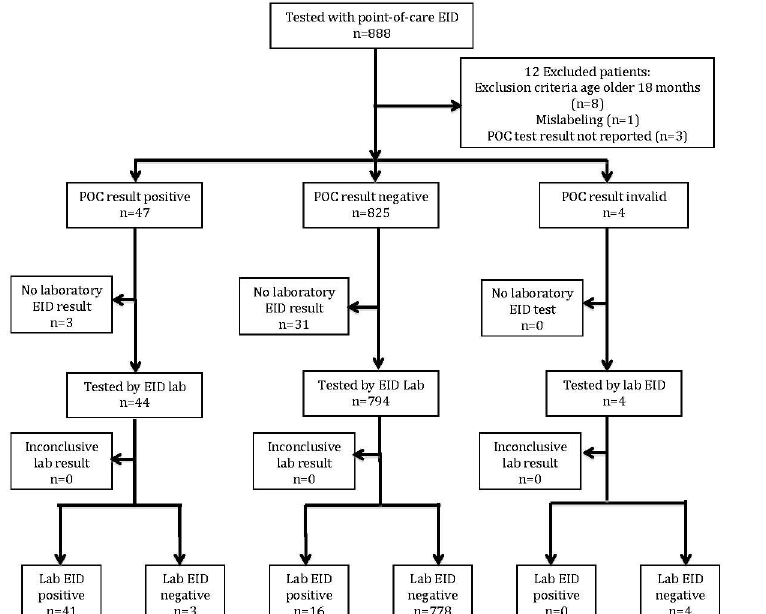
Fig 1. Flow diagram of study